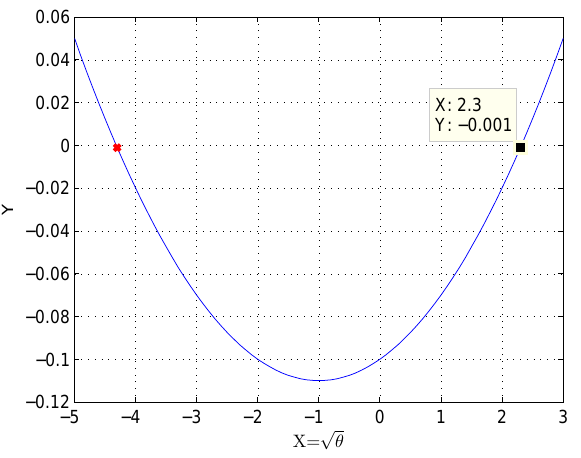
√ (cid:16) √ (cid:17) 2 + b θ θ + c